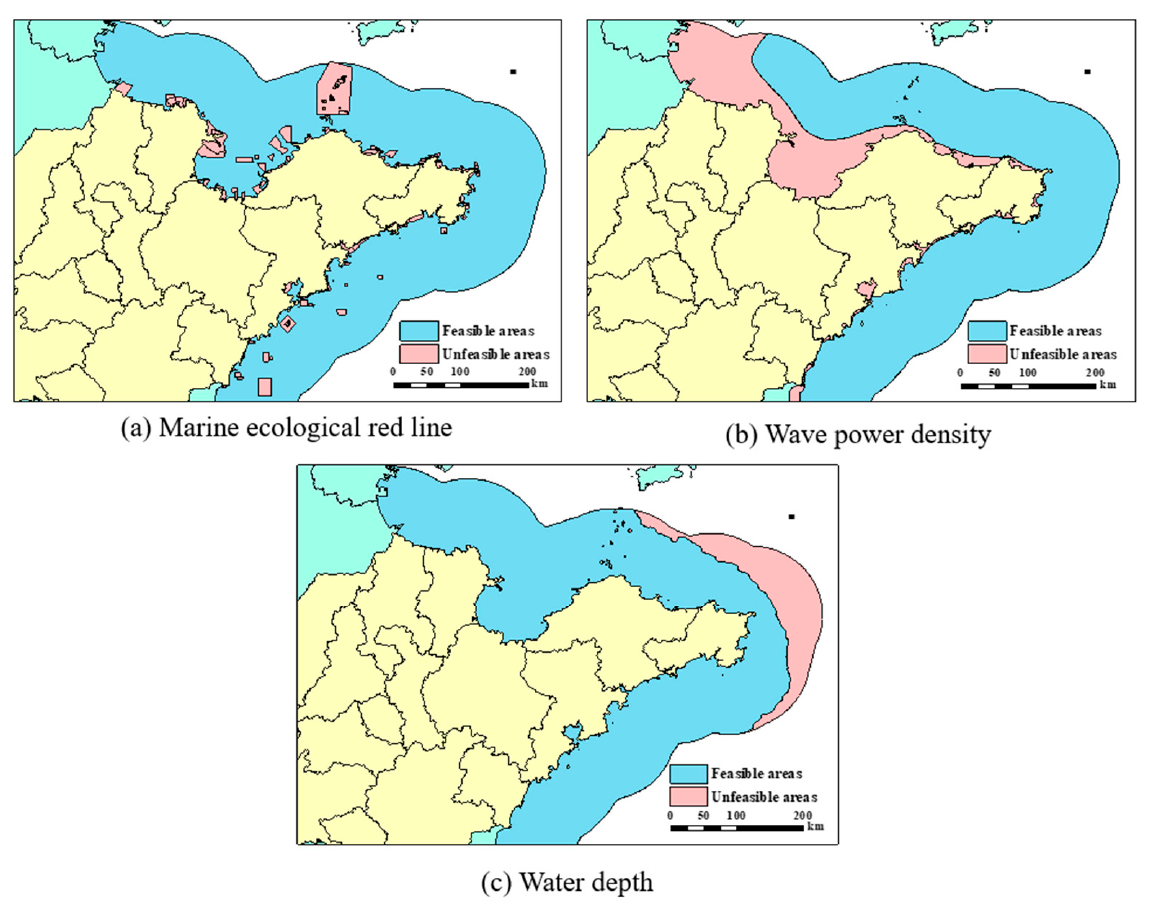
Figure 4. Unfeasible areas based on the three exclusion criteria.